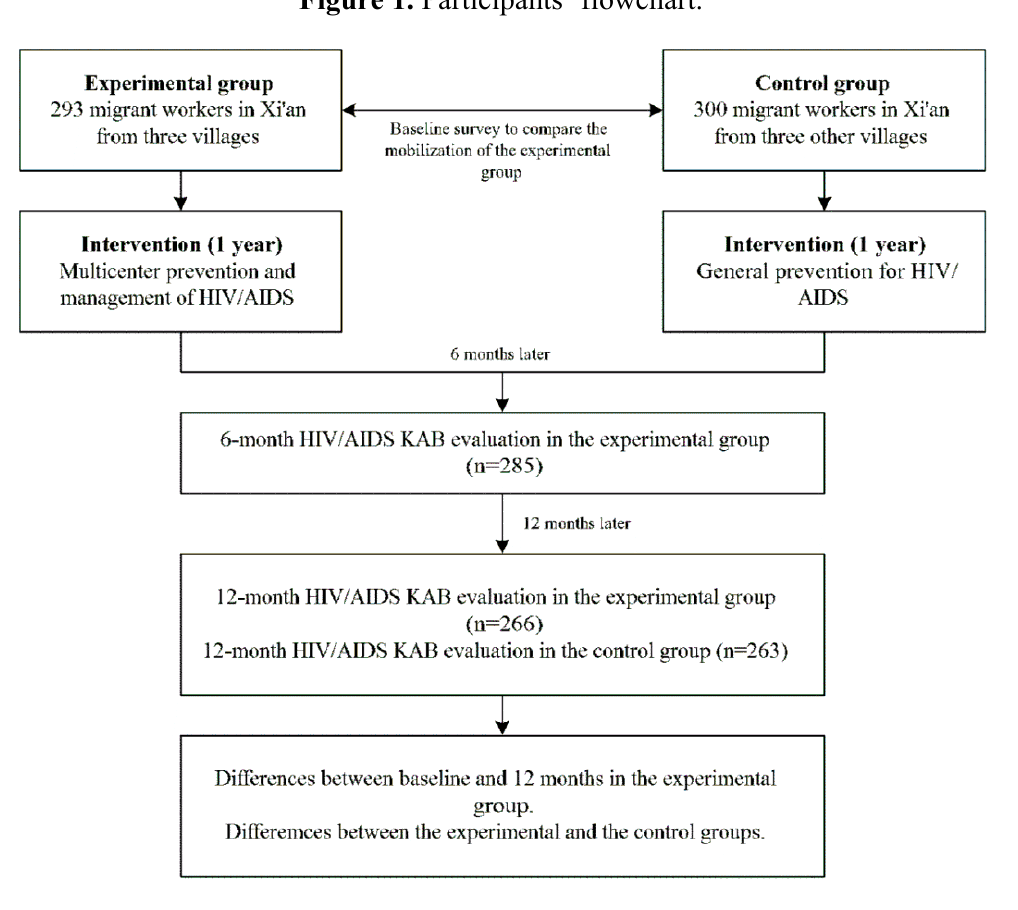
Figure 1. Participants’